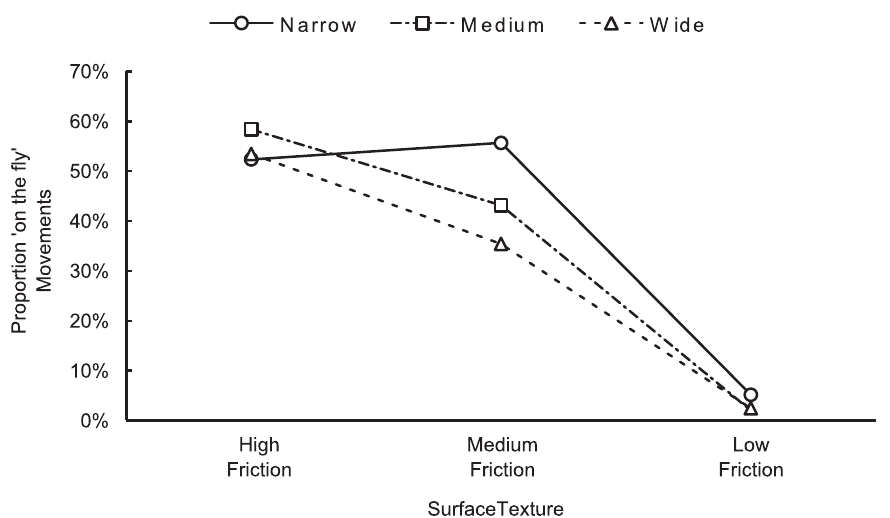
Figure 3. Proportion of ‘on-the-fly’ movements as a function of surface texture. The mean coefficient of static friction was 1.31, 0.76 and 0.44 for the high, medium and low friction object surface textures respectively (see Methods).